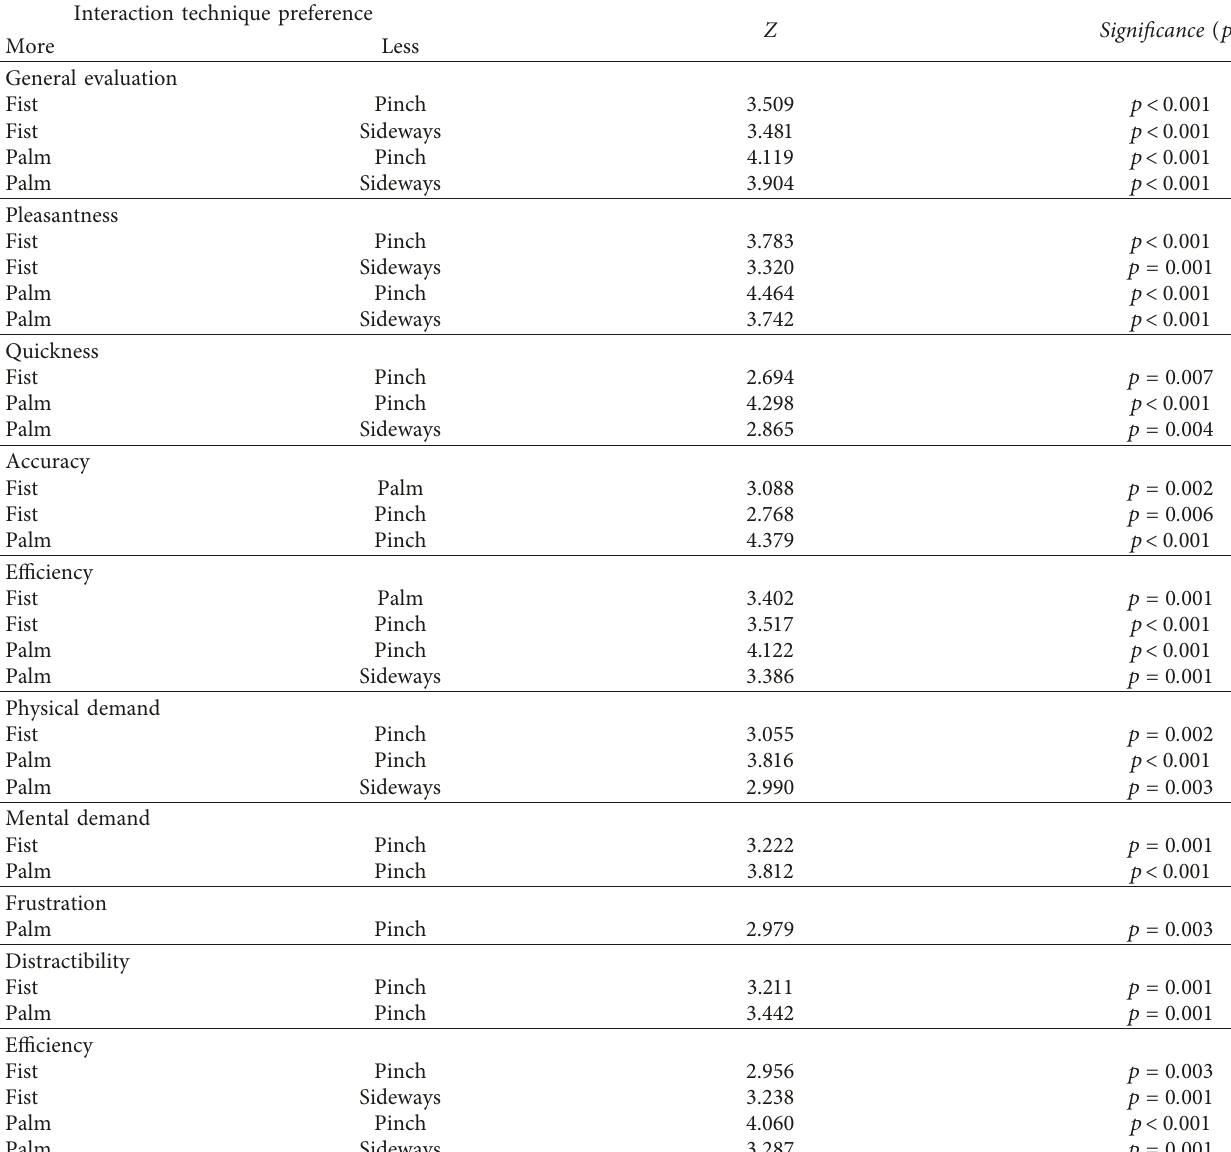
Table 6: Statistically significant reduction of participants’ subjective rating based on post hoc pairwise comparisons with Wilcoxon signed- rank test.